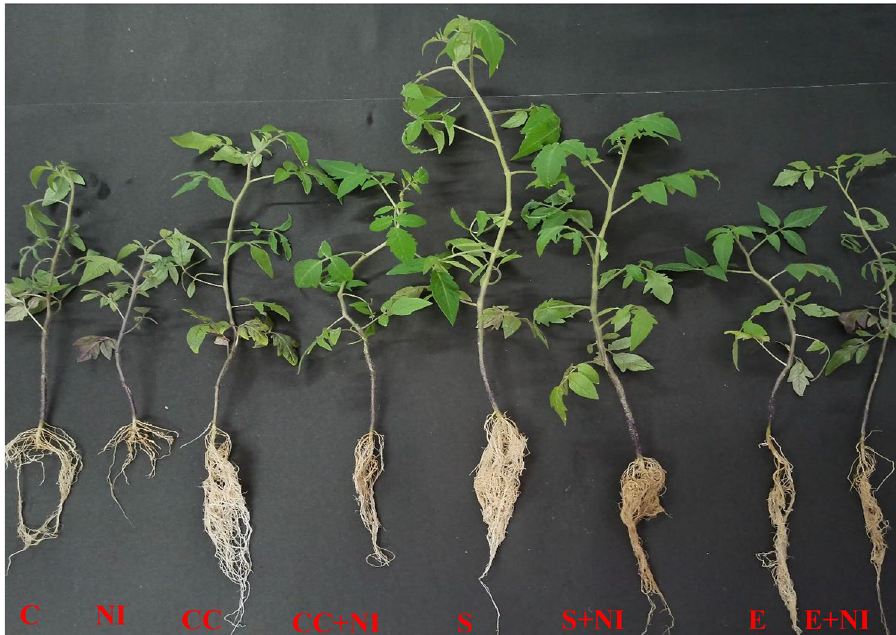
Figure 1. Figure depicting root length and shoot length of differently treated tomato plants. Different treatments include C (control); NI (nematode inoculated); CC (culture cells); CC + NI (culture cells + nematode inoculated); S (supernatant); S + NI (supernatant + nematode inoculated); E (extract); E + NI (extract + nematode